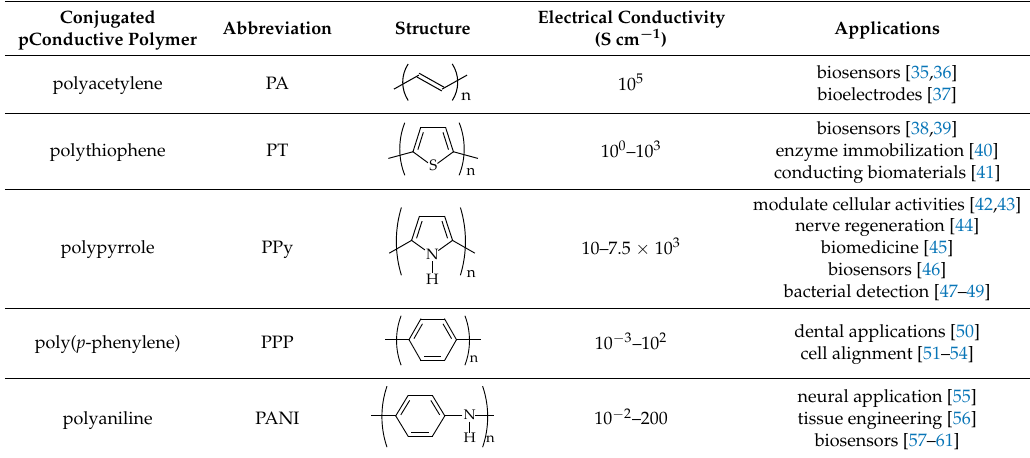
Table 1. Conjugated conductive polymers (ICPs) [7].